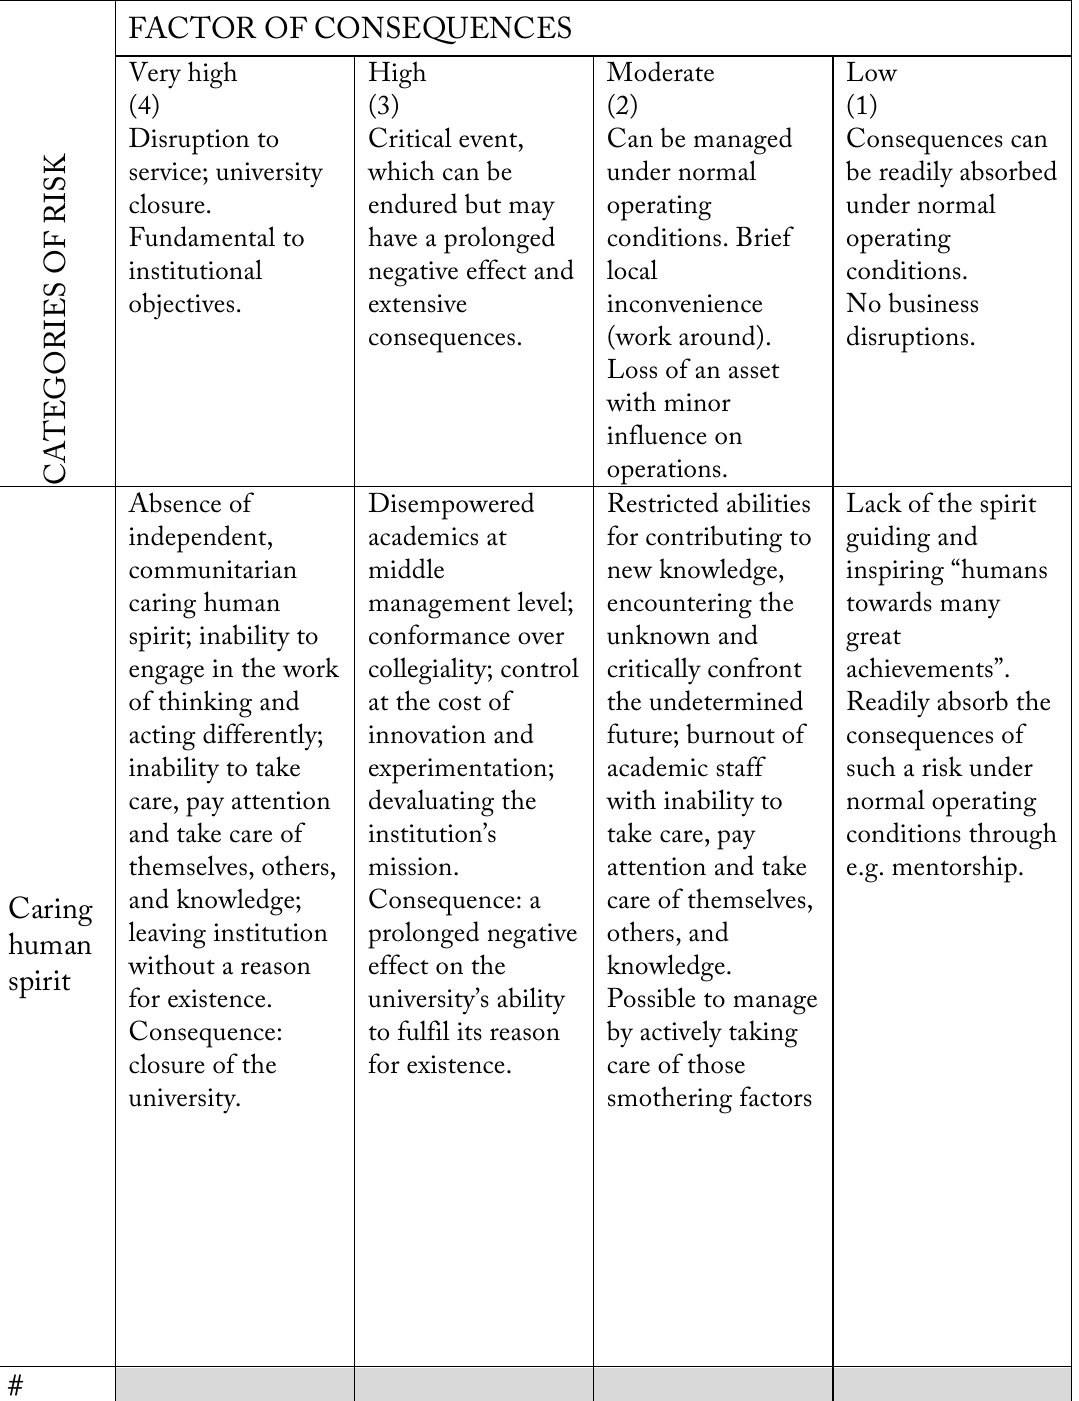
S I R F O S E I R O G E T A C